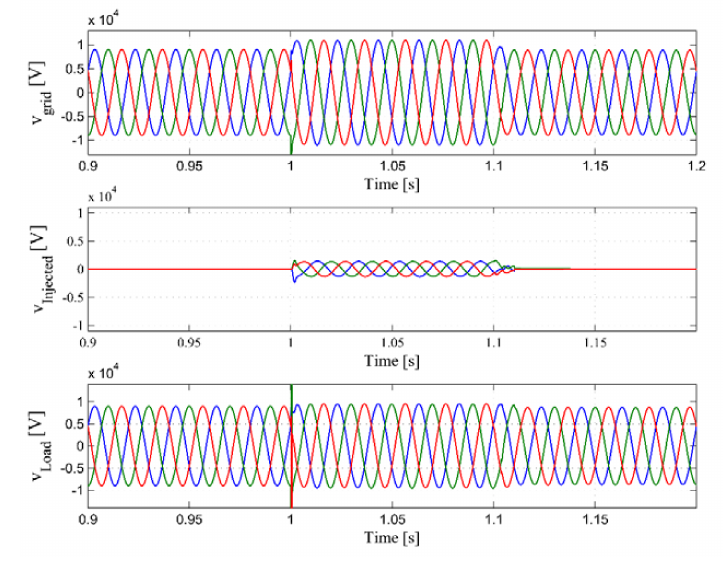
Figure 15. Case 4: Balanced voltage swell: grid voltage, injected voltage of the DVR and load voltage.